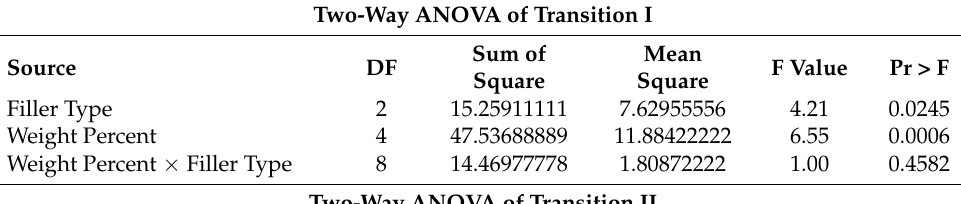
Table 2. p -Values From Pairwise Comparisons For Transition I, II, and III Temperatures. Results From